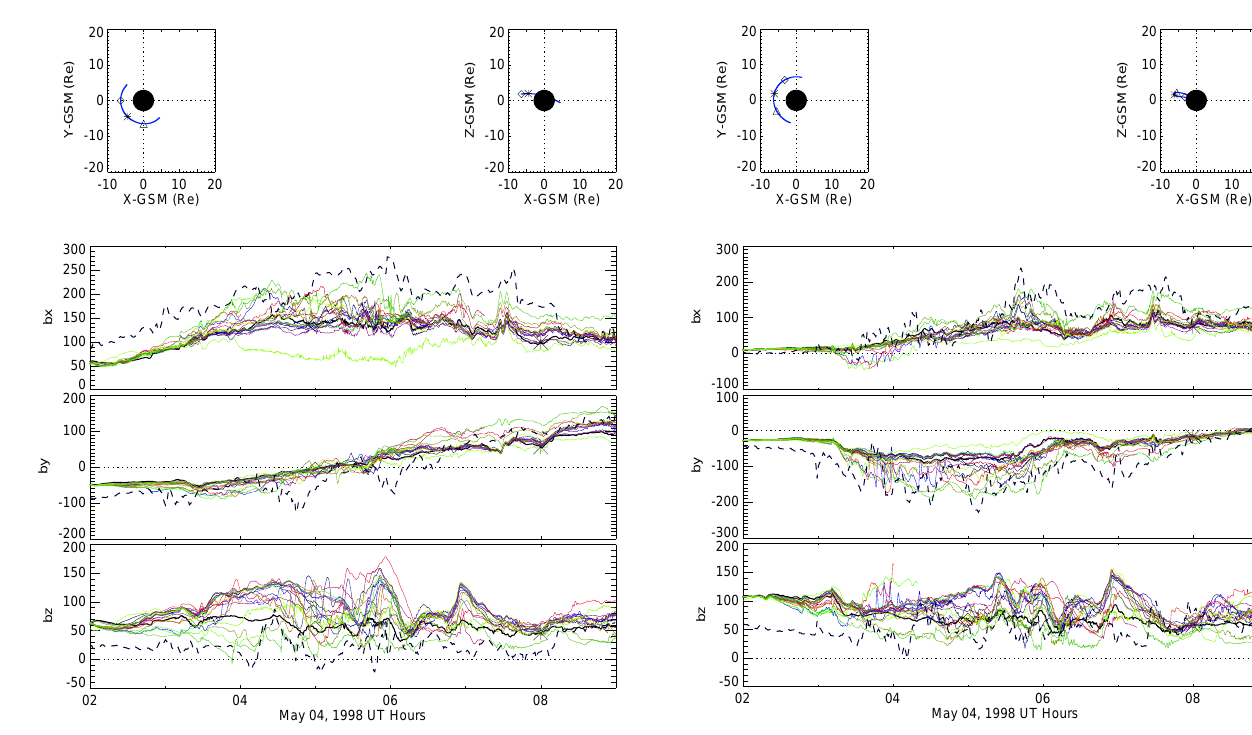
Fig. 15. Comparison with the GOES-08 satellite. The top two plots show the location of the satellite in GSM coordinates, with the dia- mond, star and triangle indicated in all plots to show how the orbit corresponds to the data below. The bottom three plots show, from top to bottom, the Bx, By and Bz components of the magnetic field measured by the satellite (dashed black lines) and values from the simulations (colored lines). Each color represents a different simu- lation described in Table 1.